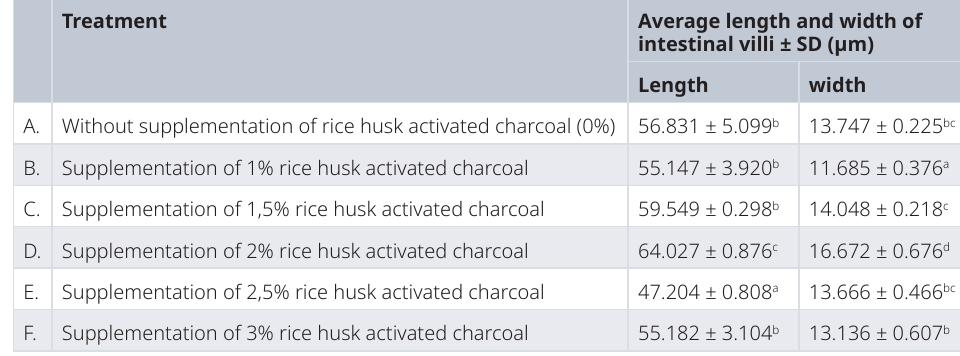
Table 5. Average length and width of giant trevally ( Caranx ignobilis ) juvenile intestinal villi.